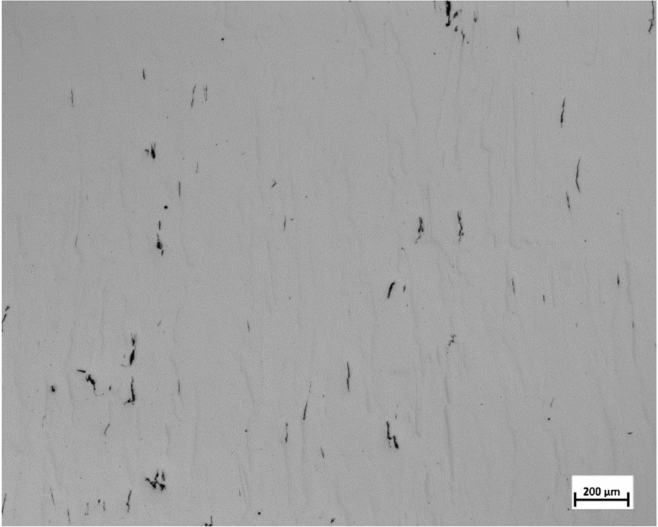
Figure 9. Typical micrograph (of Sample 3) showing prevalence of